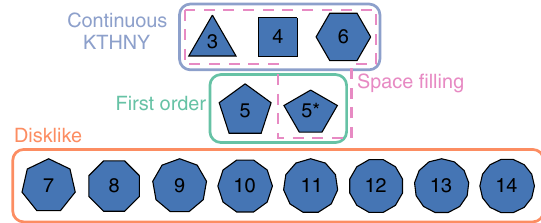
FIG. 1. The polygons studied in this work are the regular n - gons with 3 ≤ n ≤ 14 and the 4-fold pentille labelled 5 (cid:2)